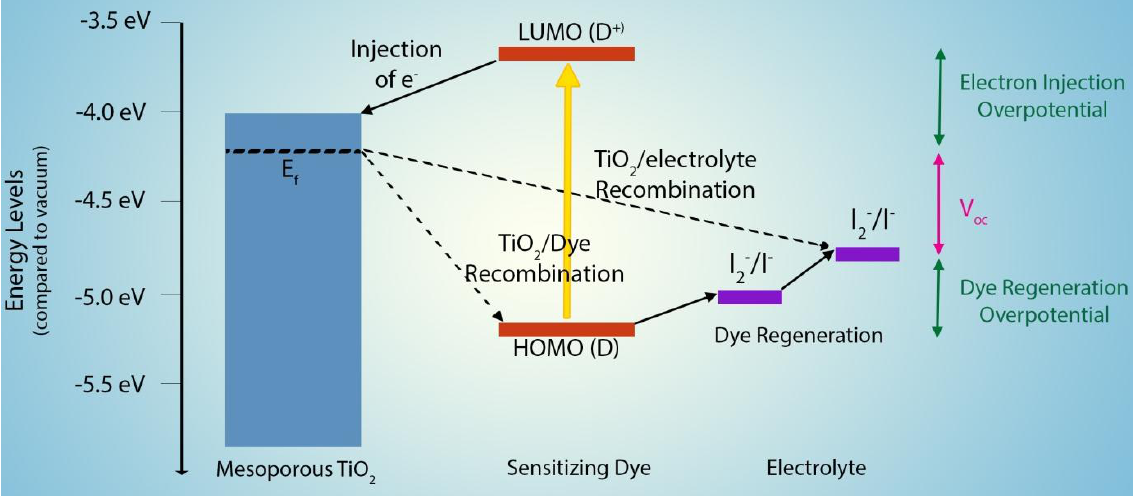
Figure 11. The energy band diagram illustrates the electron injection process: ( a ) Electron in the dye is excited to the energy level of the acceptor; ( b ) the acceptor energy level needs to correspond with the conduction band of the semiconductor to inject electron into the semiconductor; ( c ) the redox species in the electrolyte regenerates the dye; ( d ) redox species then regain electrons from the counter electrode